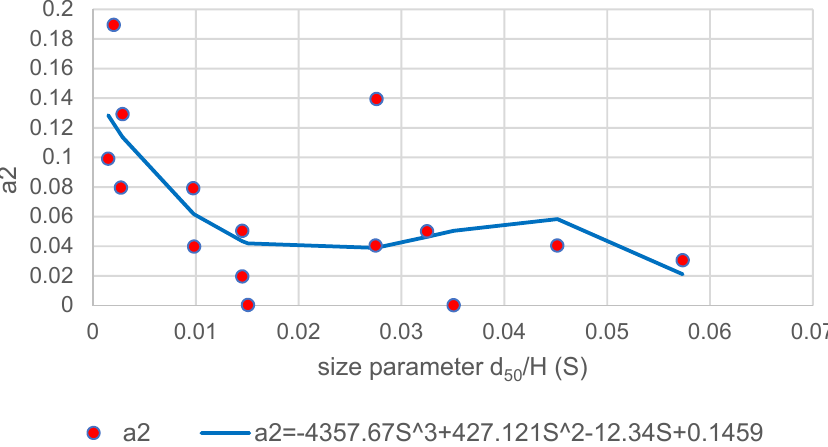
Figure 12. Size parameter vs. coefficient a 2 using KNN ( R 2 = 0.433 ).